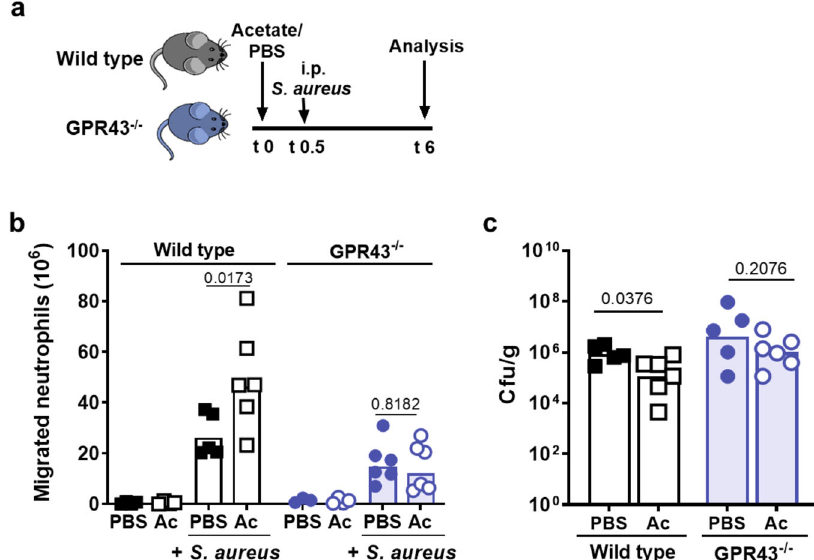
Fig. 4 Intraperitoneal acetate injection enhances neutrophil in fl ux and decreases bacterial loads in a mouse peritoneal infection model. a In the murine peritonitis model, mice were pre-treated with acetate (Ac) or PBS 30 min prior to intra-peritoneal S. aureus injection. b Acetate (Ac) treatment resulted in enhanced CD45 + Ly6G + neutrophil migration into the peritoneum compared to PBS-treated wild-type mice (black symbols) 6 h after infection. GPR43 − / − mice (blue symbols) showed reduced overall neutrophil migration into the peritoneum with no bene fi cial effect of acetate treatment. c Acetate-treated wild-type mice showed slightly reduced bacterial loads in the liver, whereas acetate treatment of GPR43 − / − mice did not in fl uence bacterial loads. Data in panels b and c represent geometric means from six animals. * P < 0.05 signi fi cant difference versus the indicated PBS or wild-type control as calculated by Mann – Whitney U